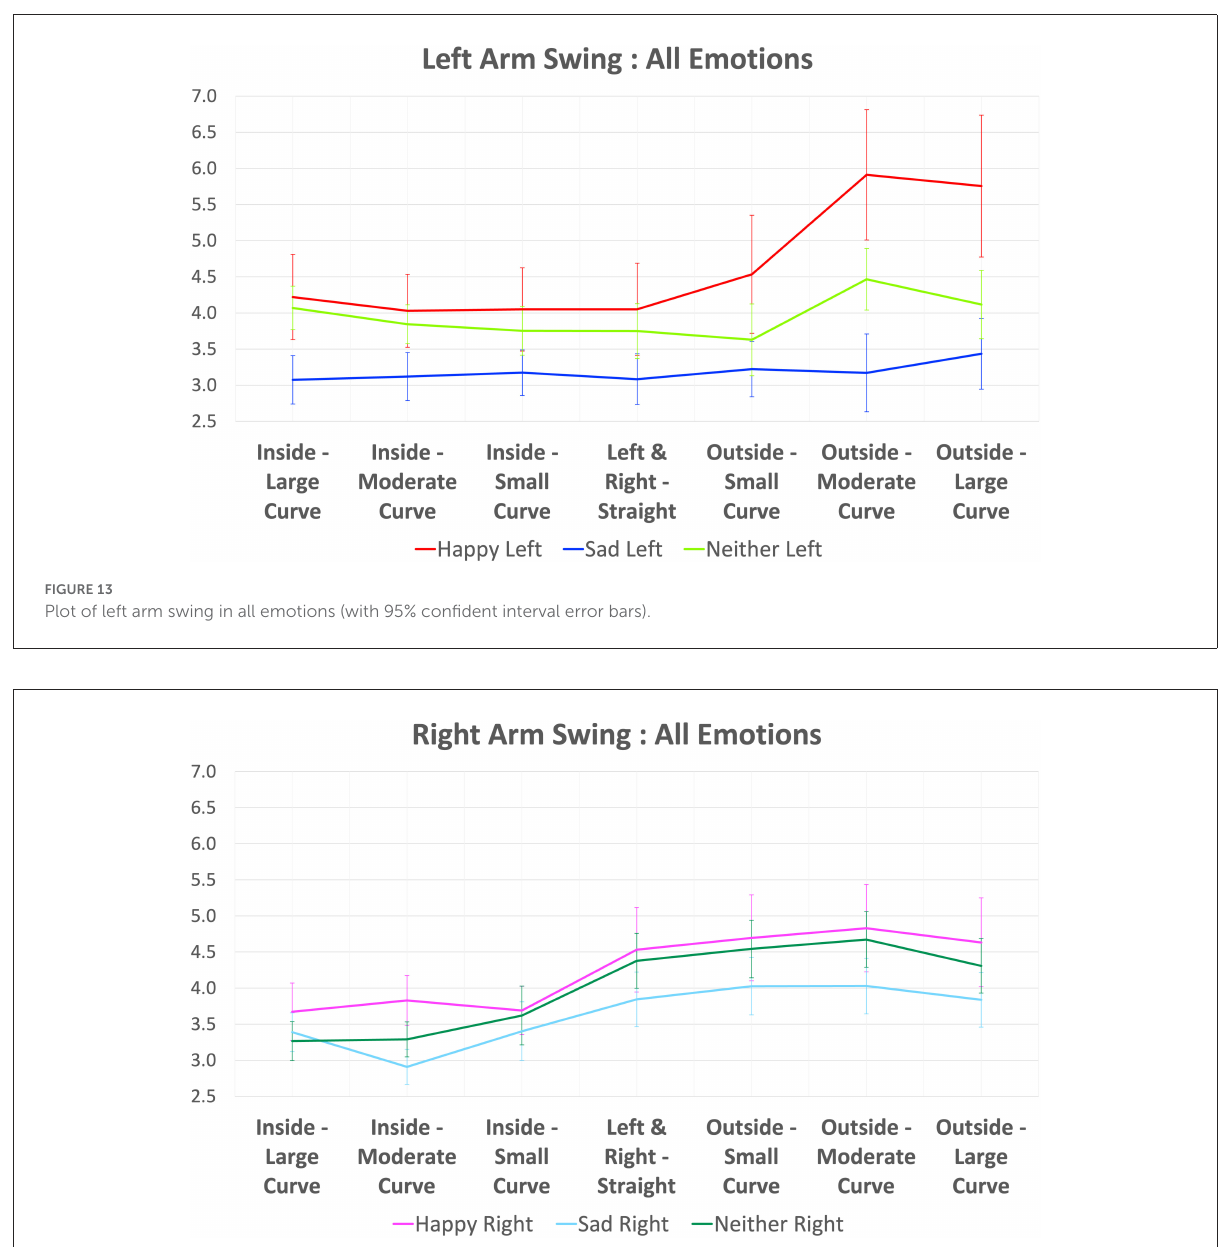
FIGURE14 Plot of right arm swing in all emotions (with 95% confident interval error bars).